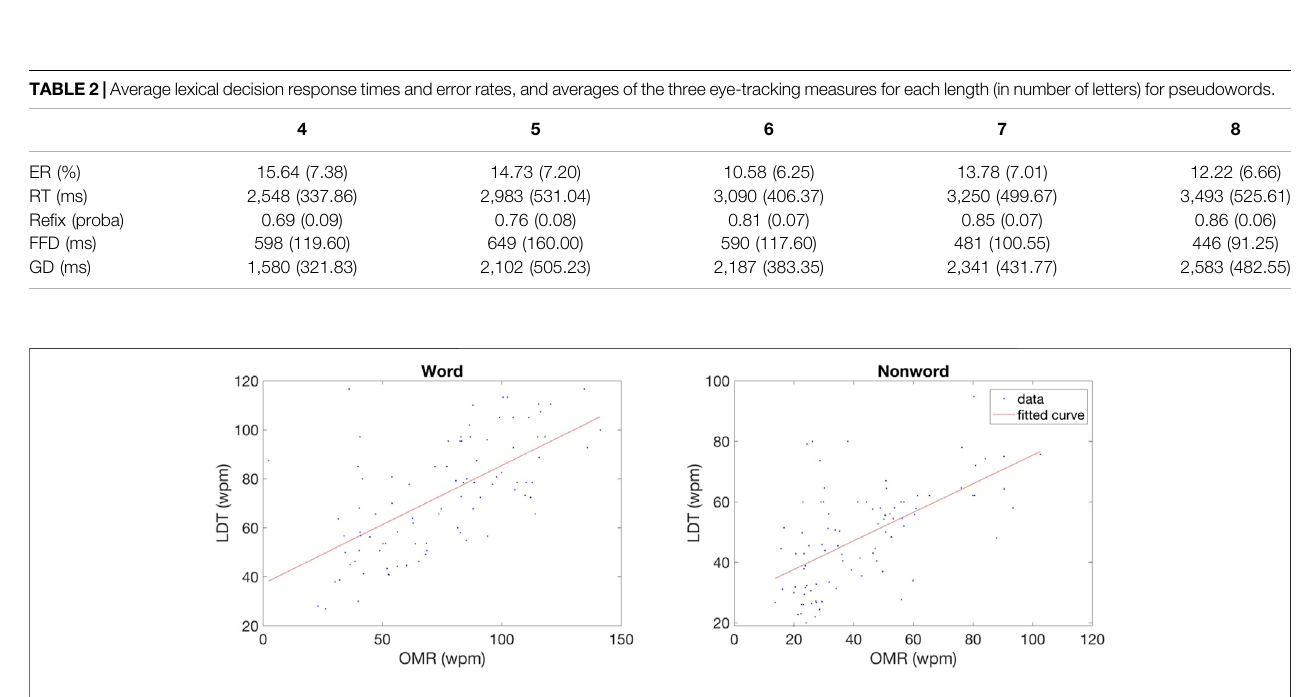
Frontiers in Education |